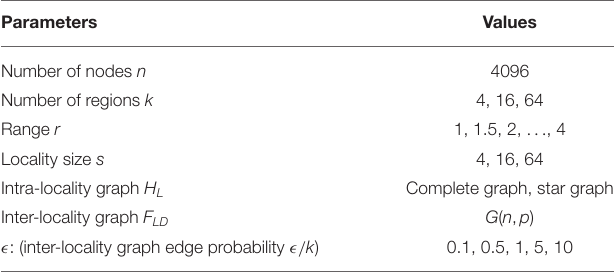
TABLE 1 | List of model parameters used in the experiments for the MPSN model. Parameters